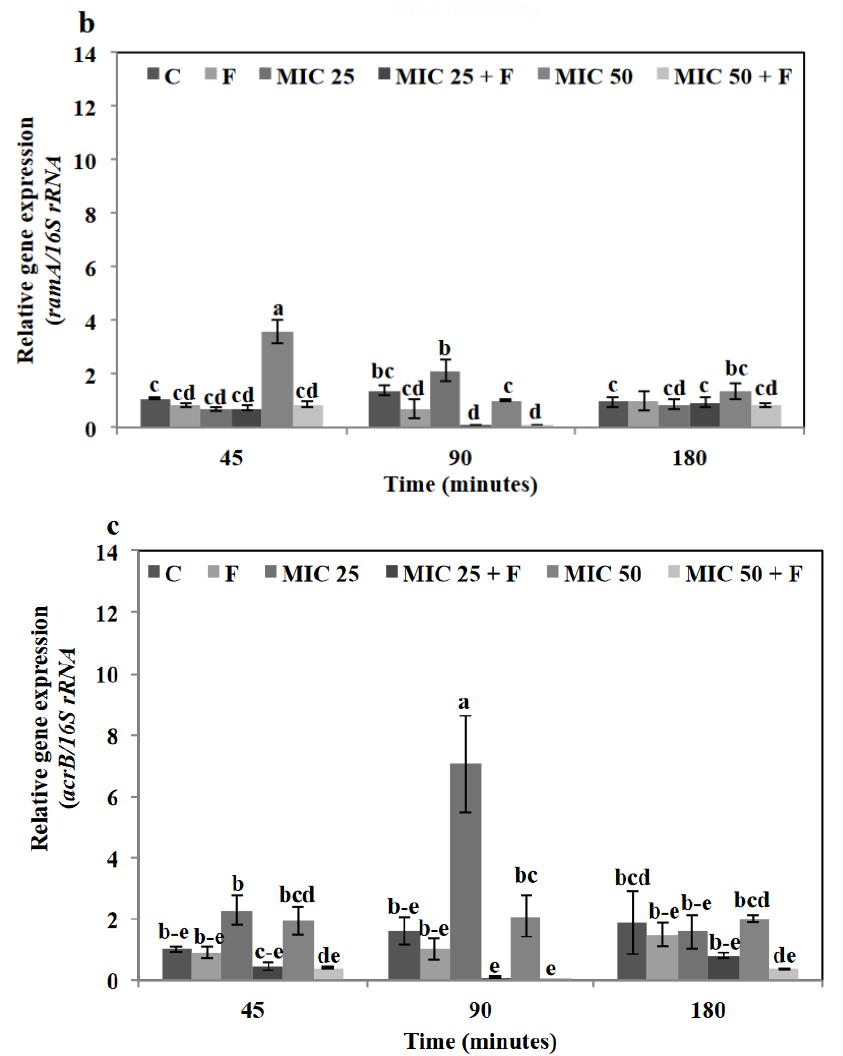
Figure 4. Effect of floridoside (F) on the expression of efflux-pumps related genes of S. Enteritidis. ( a ) marA ( b ) ramB ( c ) acrA after 45, 90 and 180 min of treatment with floridoside (15 μg/mL and Tetracycline (MIC 25 and MIC 50 , 4 and 7.9 μg/mL)). Values with different superscript letters were significantly different ( p < 0.05). C: control; F: floridoside; MIC 25: tetracycline at MIC 25 ; MIC25 + F: combination of tetracycline at MIC 25 and floridoside; MIC 50: tetracycline at MIC 50 ; MIC50 + F: combinations of tetracycline at MIC 50 and floridoside. Values represented mean ± standard deviation from three independent experiments ( n = 9).